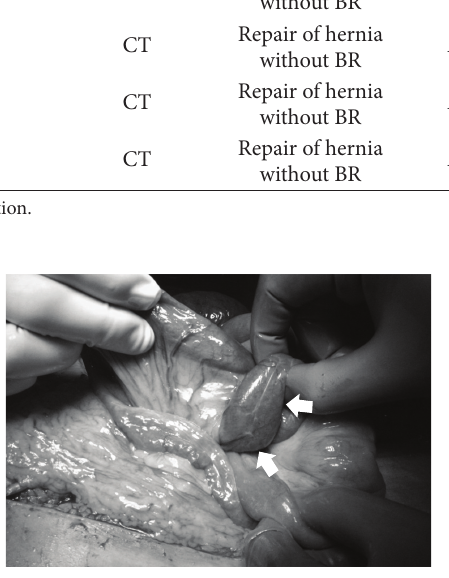
Figure 2: Photograph of operative findings. Internal hernia was evident through the rent of the mesentery around the Roux-en-Y limb of the hepaticojejunostomy (arrow: small intestine through the hernia